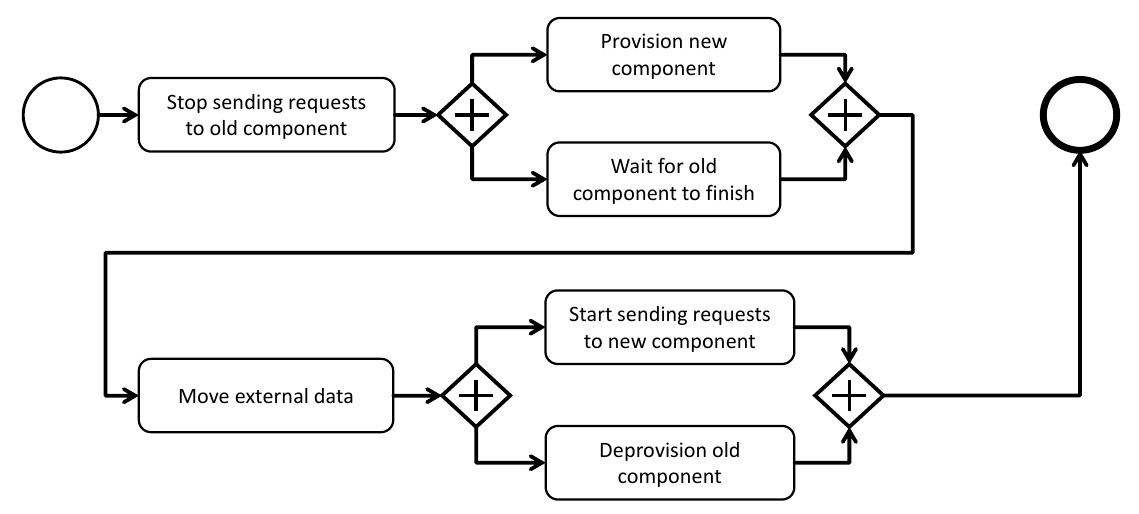
Figure 12. Abstract Management Flow of the Move/Update Management with Downtime